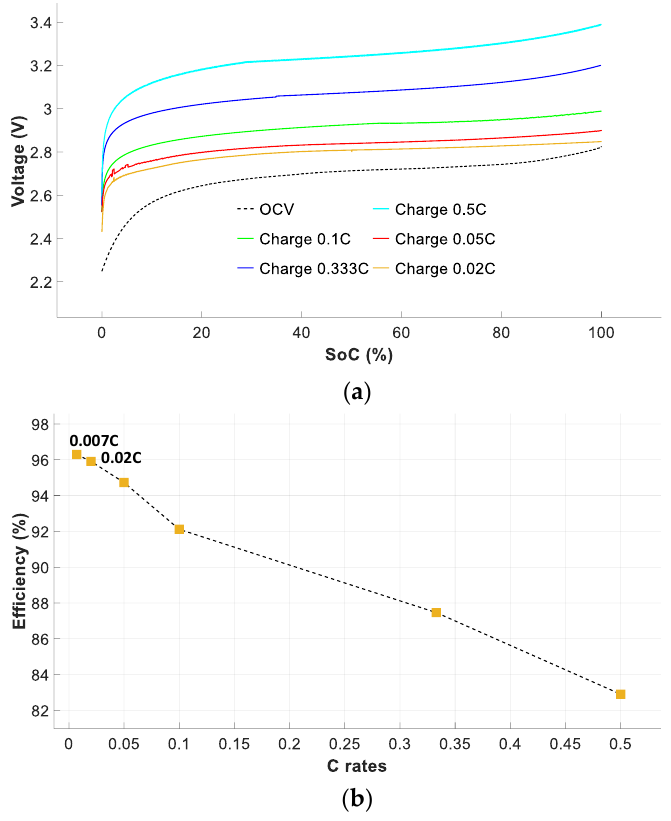
Figure 9. Battery pack performance during the charge cycle. ( a ) Voltage curves as a function of SoC . ( b ) Battery charge efficiencies at different current rates.